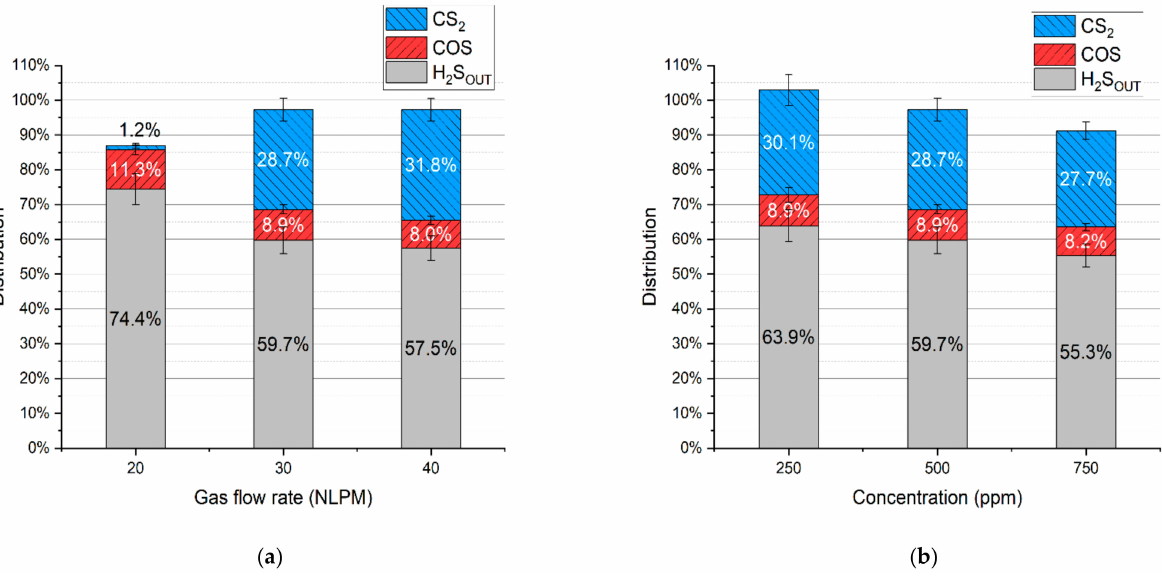
Figure 7. Distribution of sulfur in the products depending on: ( a ) gas flow rate and ( b ) initial hydrogen sulfide